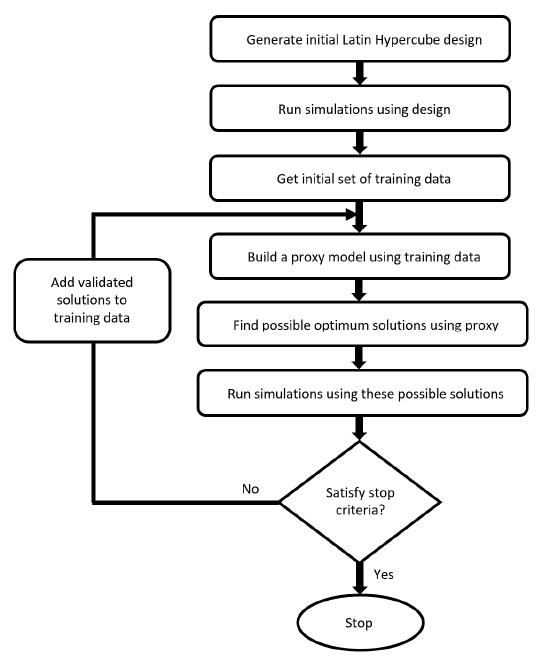
Figure 4. Optimization algorithm in Latin Hypercube plus proxy optimization (adapted from